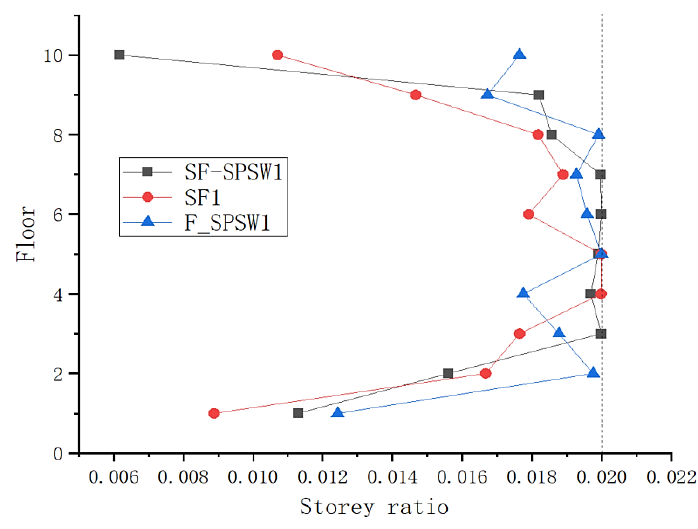
Figure 17. Story drift ratio of SF-SPSW 1 and SF 1.